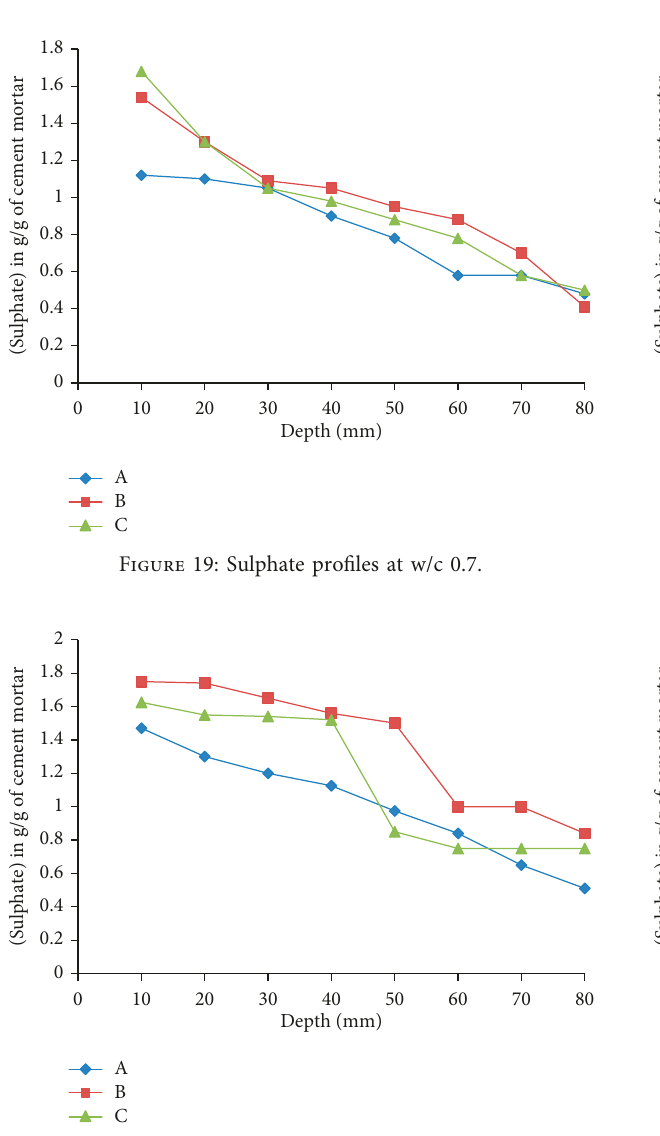
Figure 22: Sulphate profiles at w/c